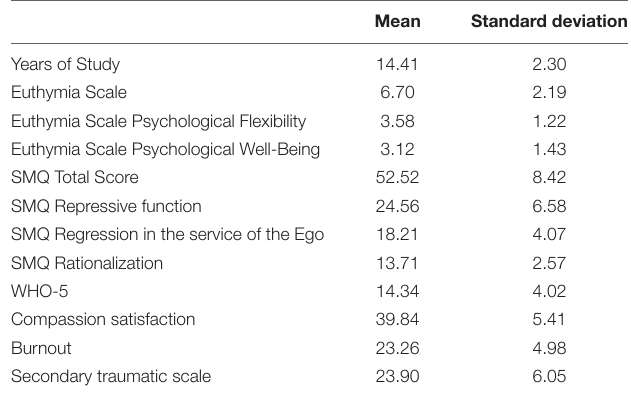
TABLE 1 | Descriptive statistics for study